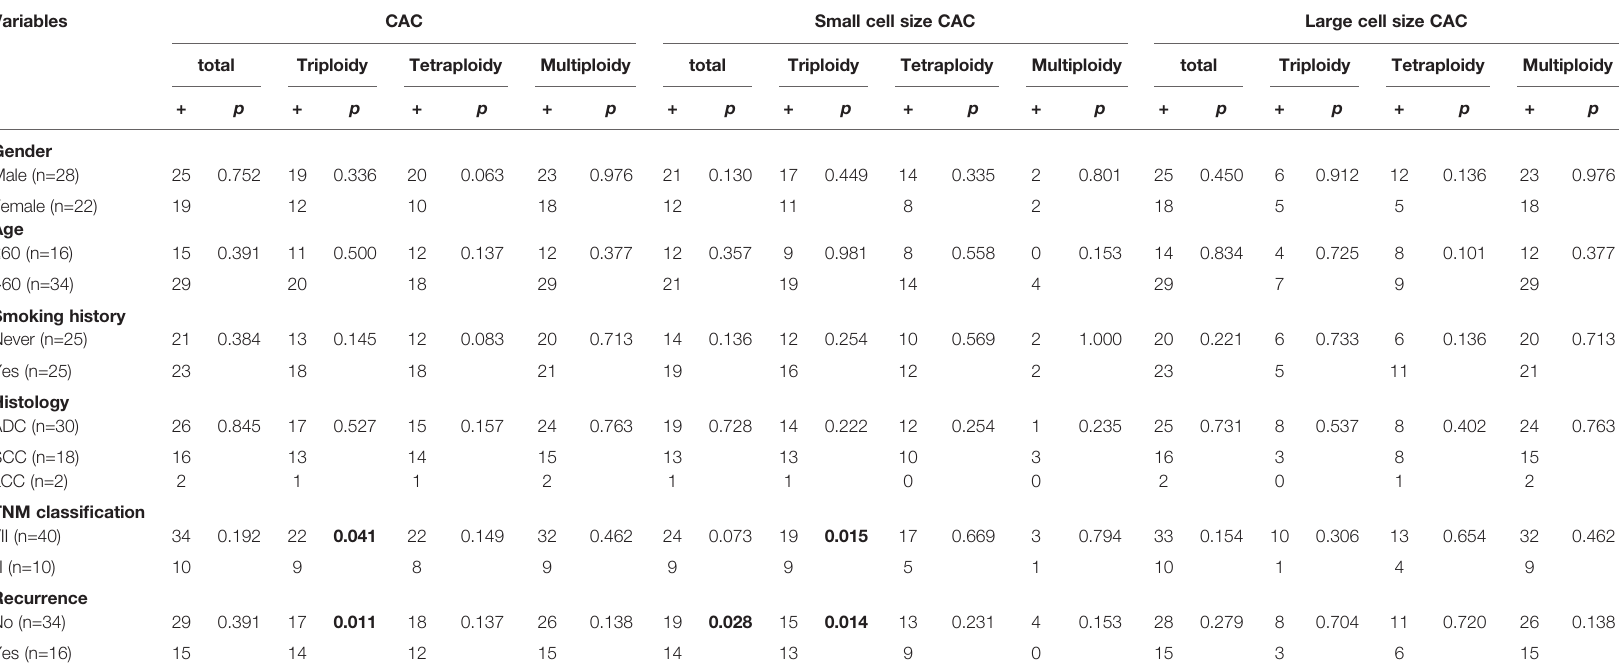
TABLE 3 | Correlation between pre-surgery CAC and clinical characteristics (n =